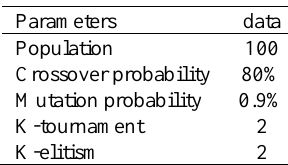
Table 2. The GA’s Parameters for dataset used.